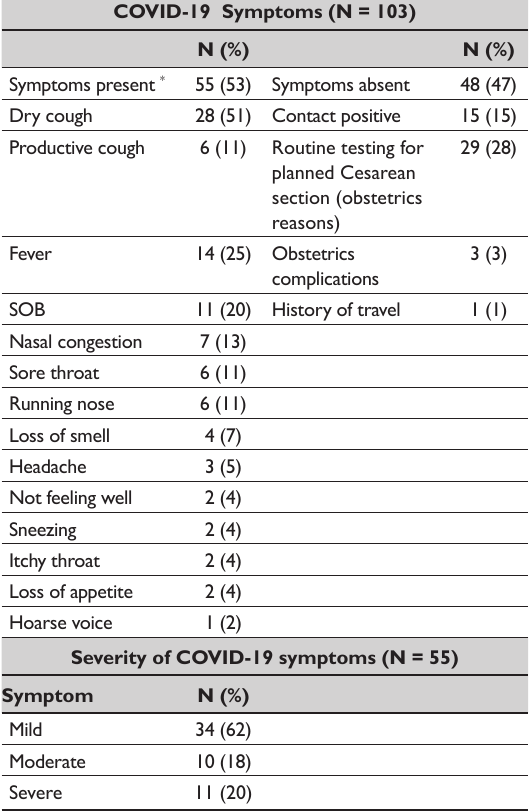
Table 2: Types and severity of COVID symptoms among COVID-19 positive pregnant